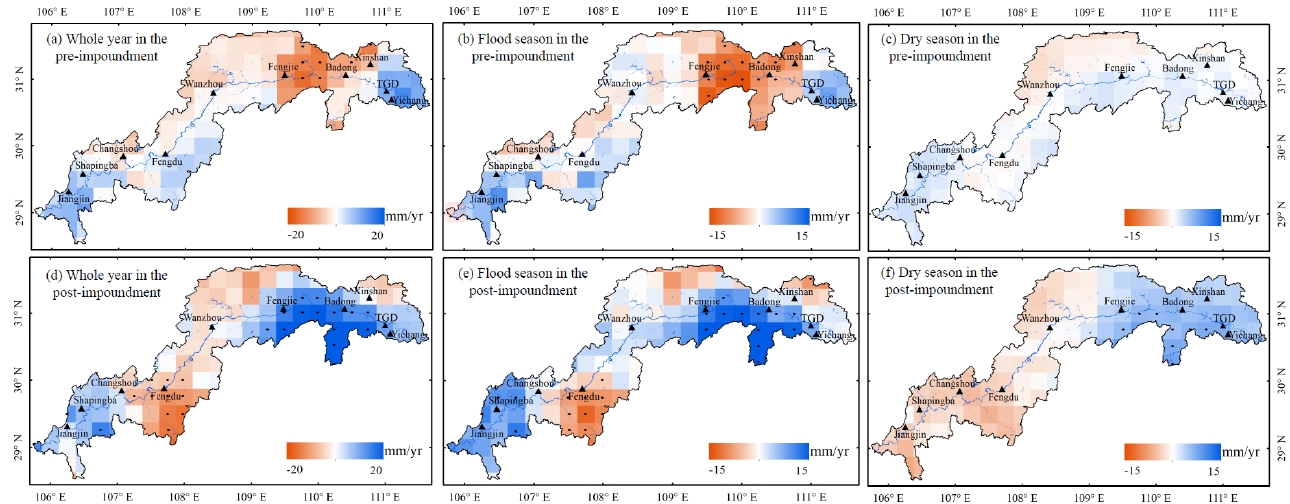
Figure 6. Distribution of precipitation anomaly trends before the impoundment for the ( a ) whole year, ( b ) flood season, ( c ) dry season, and after the impoundment for the ( d ) whole year, ( e ) flood season, and ( f ) dry season; the black point stands for that the pixel has passed the significance test ( P value < 0.05).